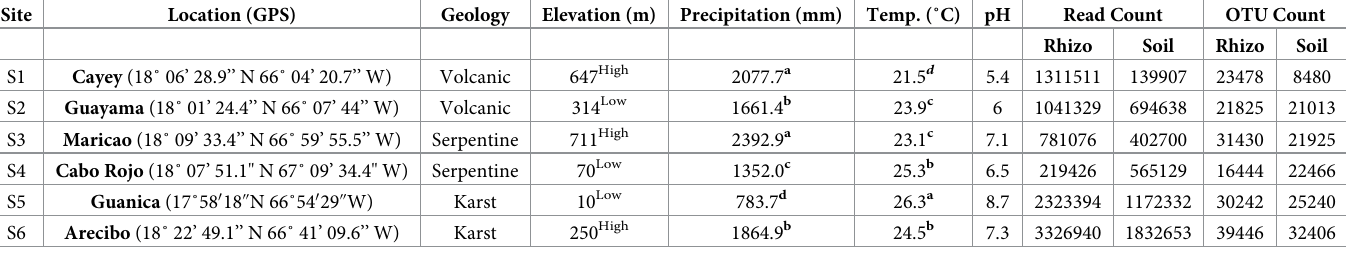
Table 1. Physical properties of the sites used in this study and their respective number of OTUs and sequences corresponding to sum of all samples (replicates and trees) per site. Analyses henceforth were done with a rarefaction level of 30,170 sequences per sample, corresponding to the sample with the lowest read count. Site Location